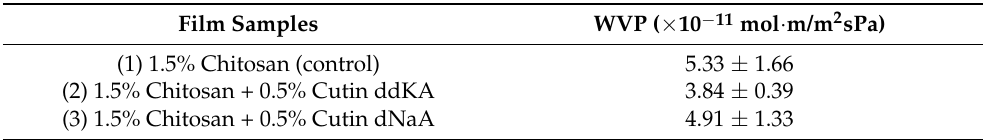
Table 13. Water Vapor Permeability values of the selected film